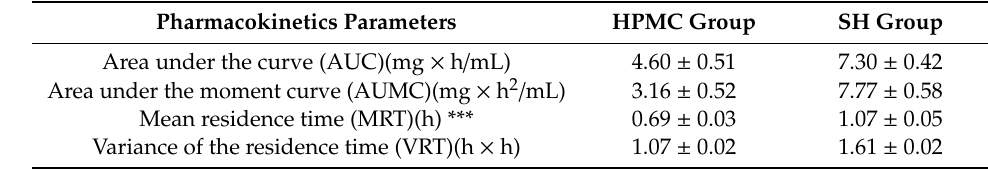
Table 3. Parameters based on statistical moment theory for AZI in tear fluid after topical administration in the conscious rabbits ( n =